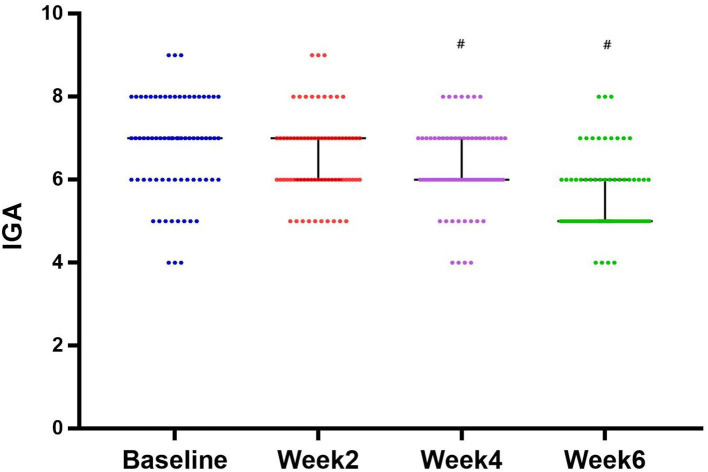
Evolution of IGA score from baseline and after 2, 4, and 6 weeks of treatment (median with 95% CI). #P < 0.05.